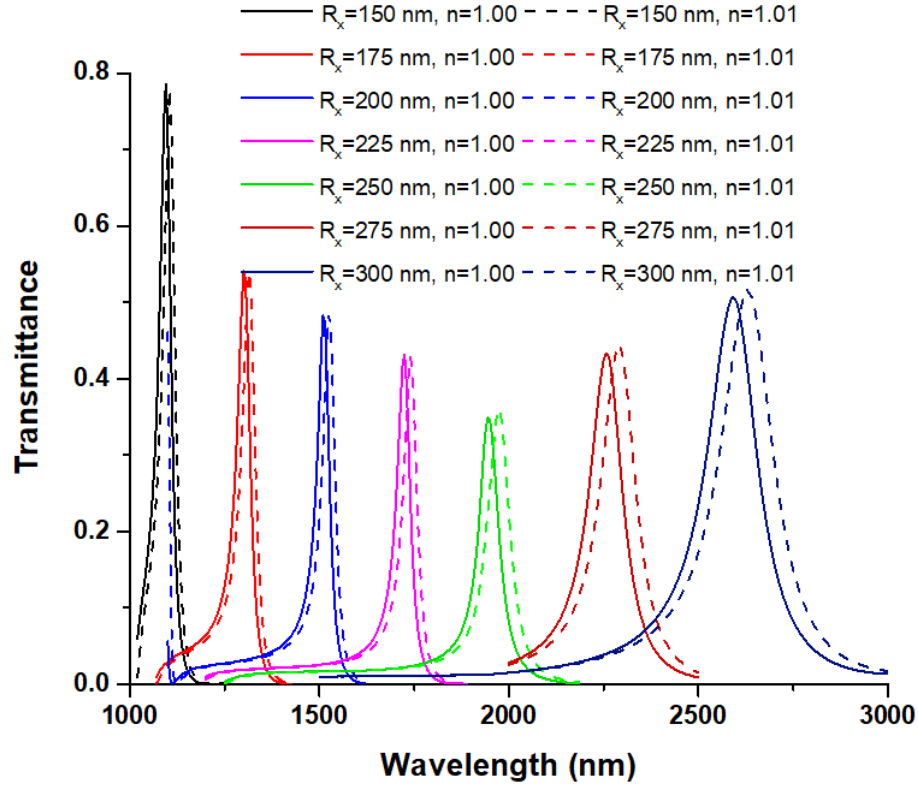
Figure 6. Transmittance spectrum of case 4 by changing R x = (150, 175, 200, 225, 250, 300) nm and the RI ( n ) of surrounding material varying from 1.00 to 1.01.